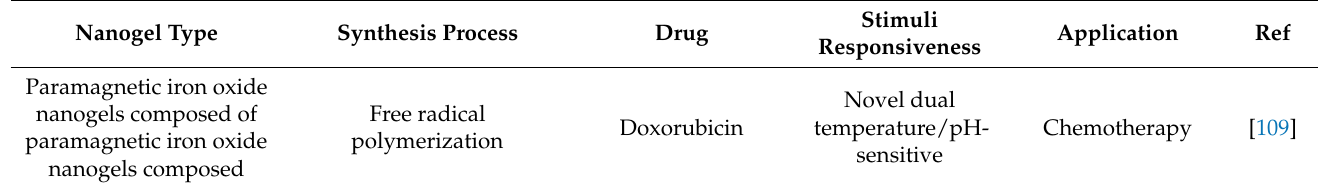
Table 1. Multi-stimuli-responsive nanogels and their use in biomedical